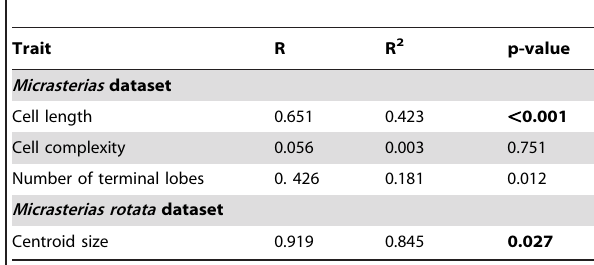
Table 4. Correlation between the 1C DNA content and selected cell morphometric